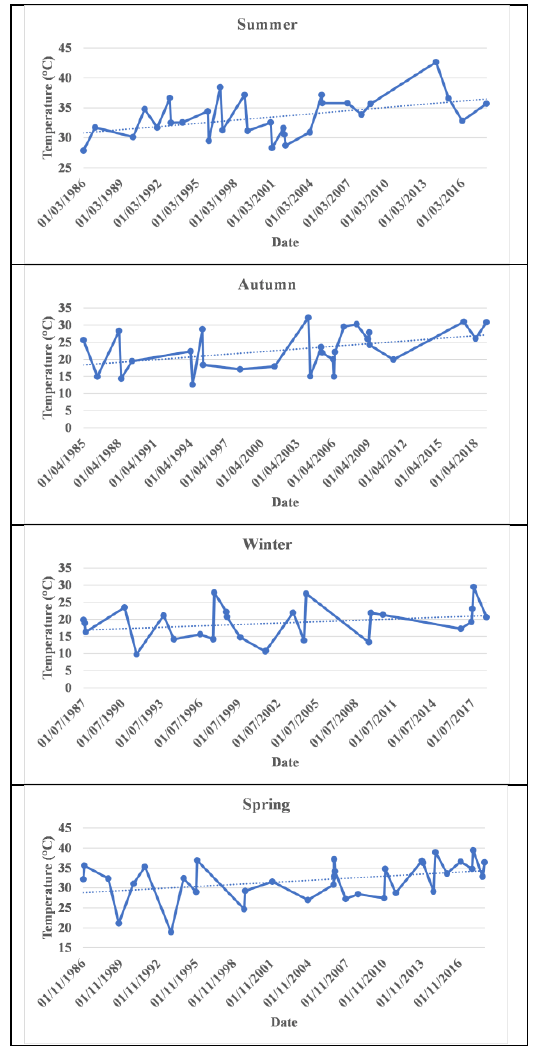
Figure 4. Surface temperature variations by season from 1985 to 2019 obtained from the mean temperature of the entire study